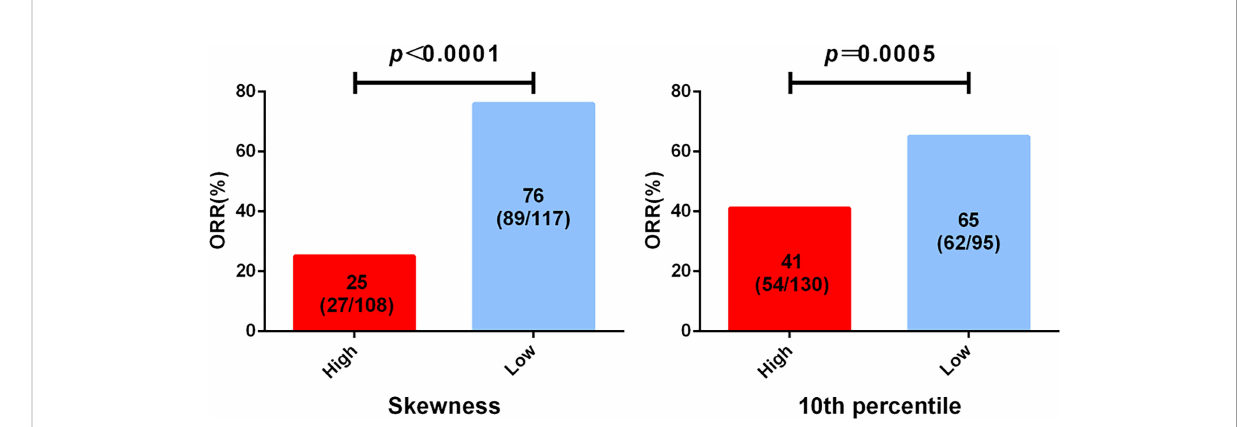
FIGURE 3 Analysis of epidermal growth factor receptor (EGFR) mutation-associated features from computed tomography (CT) imaging before treatment and the best clinical response to tyrosine kinase inhibitor (TKI) fi rst-line therapy. All patients were divided into two groups according to the cutoff of skewness and 10th